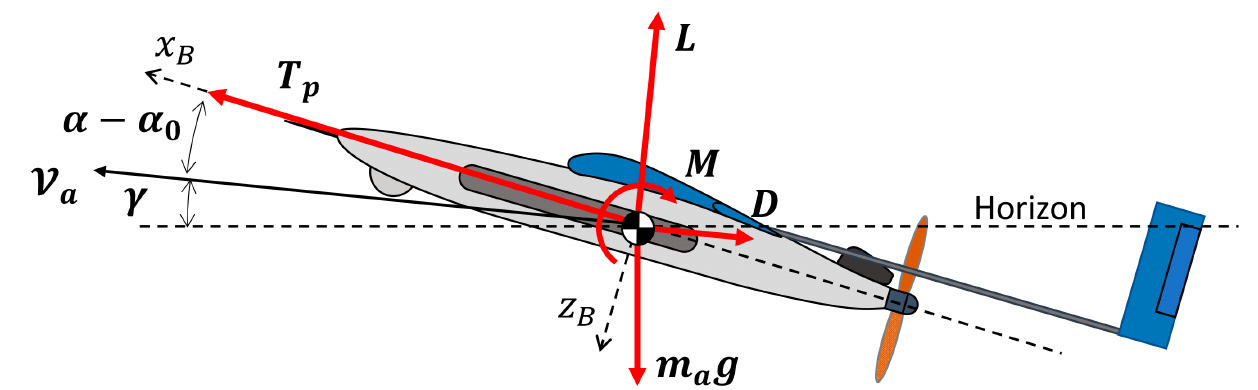
Figure 7. Reference schematics for the UAV longitudinal phugoid dynamics.